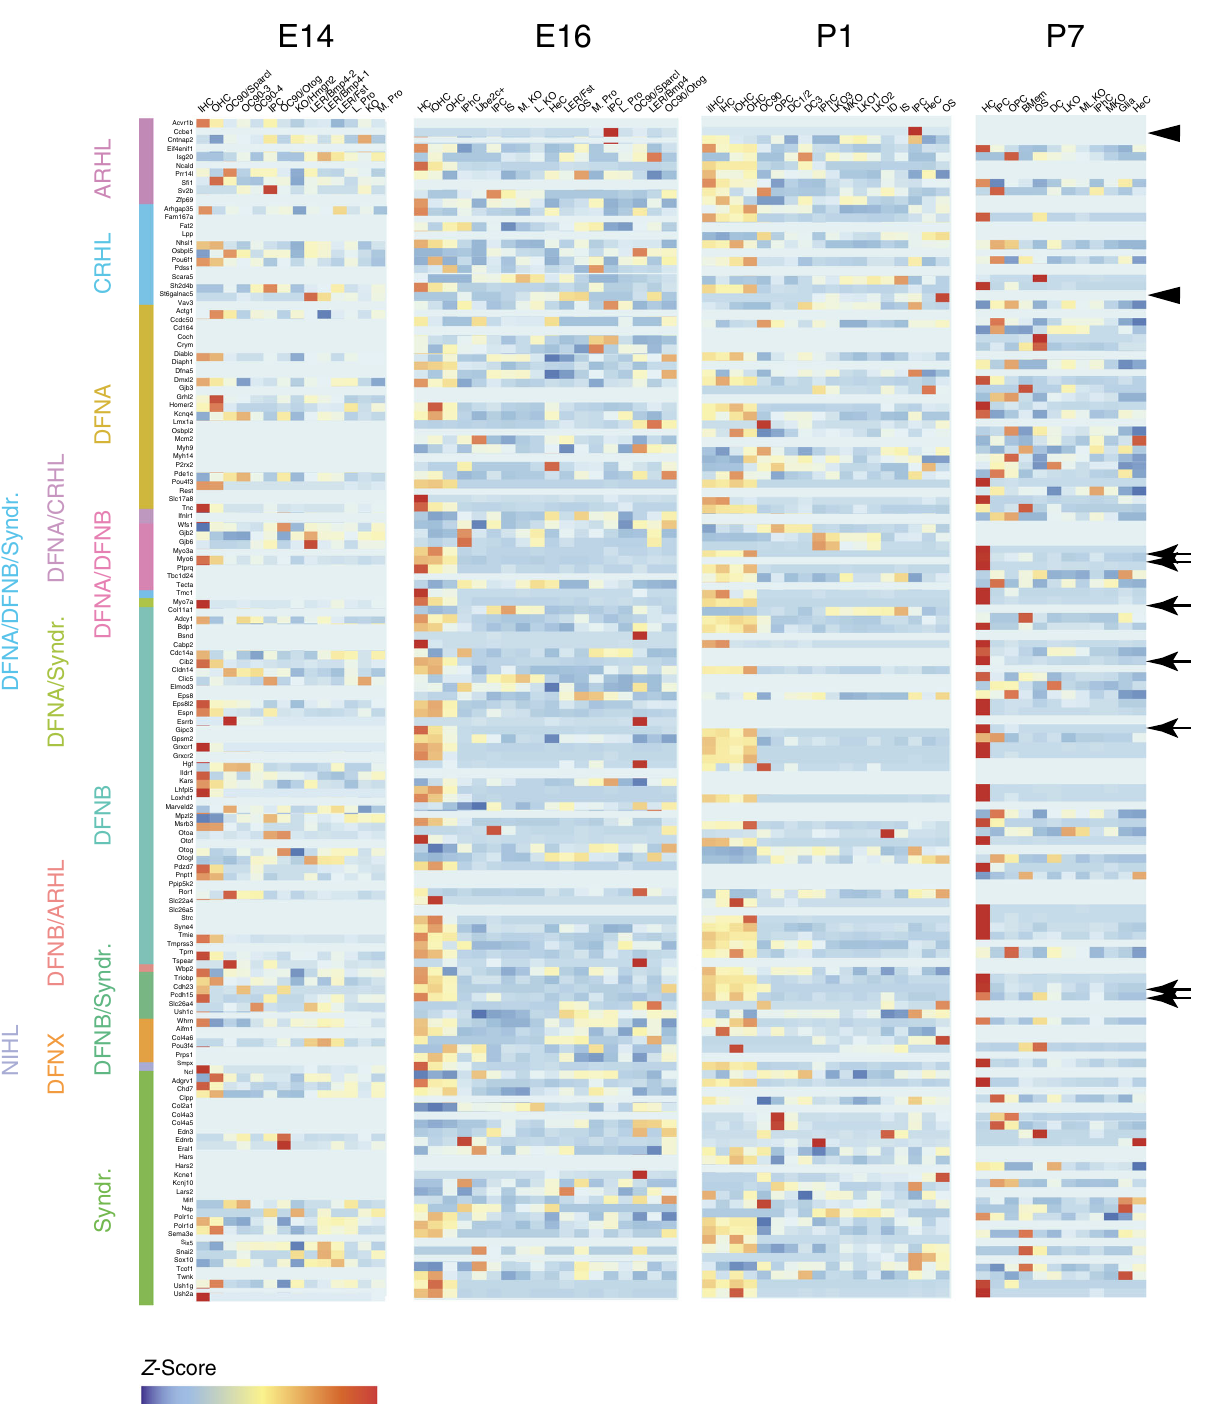
Fig. 7 Localization of deafness genes. Heat maps illustrating cell-type-speci fi c expression (as a z -score for cell-type-averaged expression) for deafness- related genes in cochlear cell clusters from E14, E16, P1, and P7. Cluster identitities for each time point are indicated along the top of each heat map and disease classes are indicated on the Y -axis. Consistent with previous work, many deafness genes that are known to be expressed in HCs, such as Myo6 , Myo7a , Myo3a , Cdh23 , Pcdh15 , Gipc3 , and Cip2 , show exclusive expression in HC clusters in particular at P7. Other genes that have been associated with hearing loss but not examined within the inner ear show expression in other cell types. For example, Ccbe1 , which when mutated can lead to Hennekam syndrome, is only expressed in IPCs. ARHL age-related hearing loss, CRHL cisplatin-related hearing loss, NIHL noise-induced hearing loss, Syndr.